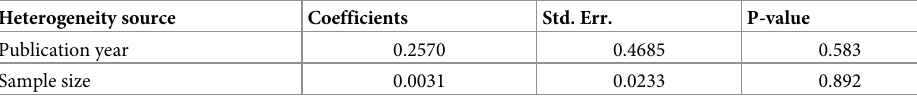
Table 2. Meta-regression analysis of factors affecting between-study